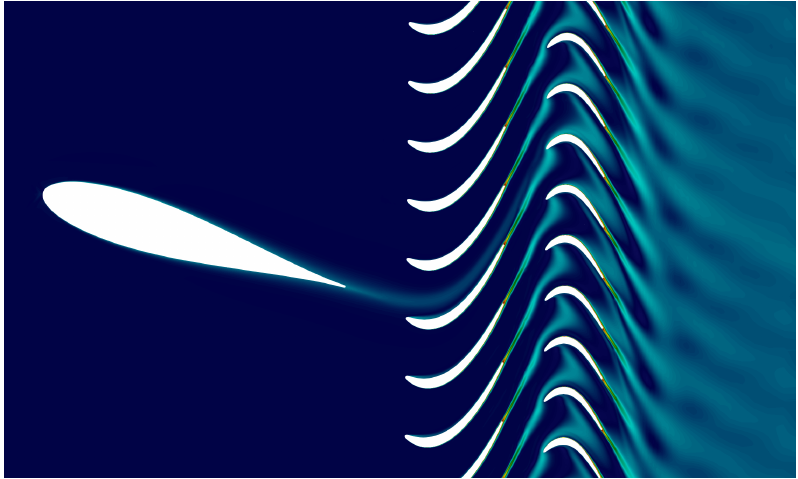
Figure 10. Instantaneous entropy contours at midspan. A run-time temporal DFT on the rotor profiles was activated during the TRAF un- steady run to decompose the time-varying fluctuations at EO = 7 and EO = 126, which correspond to the first BPF of IGV and stator, respectively. Then, the unsteady pressure distribution described by complex Fourier coefficients field acting on the rotor blade surface was circumferentially decomposed in space to extract the rotating perturbations that can excite the corresponding traveling wave mode shapes of the bladed rotor. The in-house post-processor extracts the pressure perturbation at circumferential order (cid:96) = + 7 from the EO = 7 and (cid:96) = − 21 from the harmonic at the EO = 126, accounting for the aliasing phenomenon. Considering the rotor rotational direction, the circumferential order values were converted to nodal diameters to distinguish between forward and backward traveling waves in ANSYS, so the pressure perturbation is referred to ND = − 7 backward for EO = 7 and ND = + 21 forward for EO = 126. Figures 11 and 12 show the ampli- tude and phase of the unsteady pressure perturbation circumferentially decomposed for EO = 7 and EO = 126, respectively.